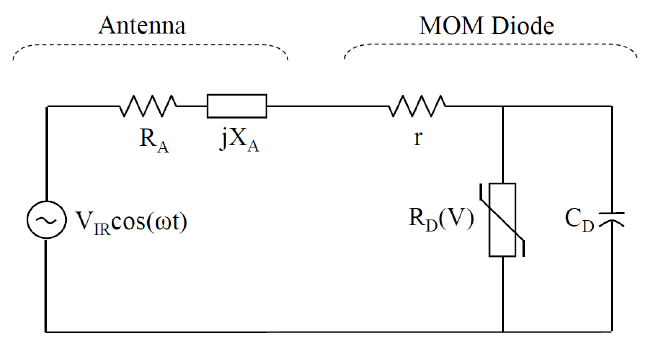
Figure 15. Equivalent-circuit model of an antenna-coupled MOM